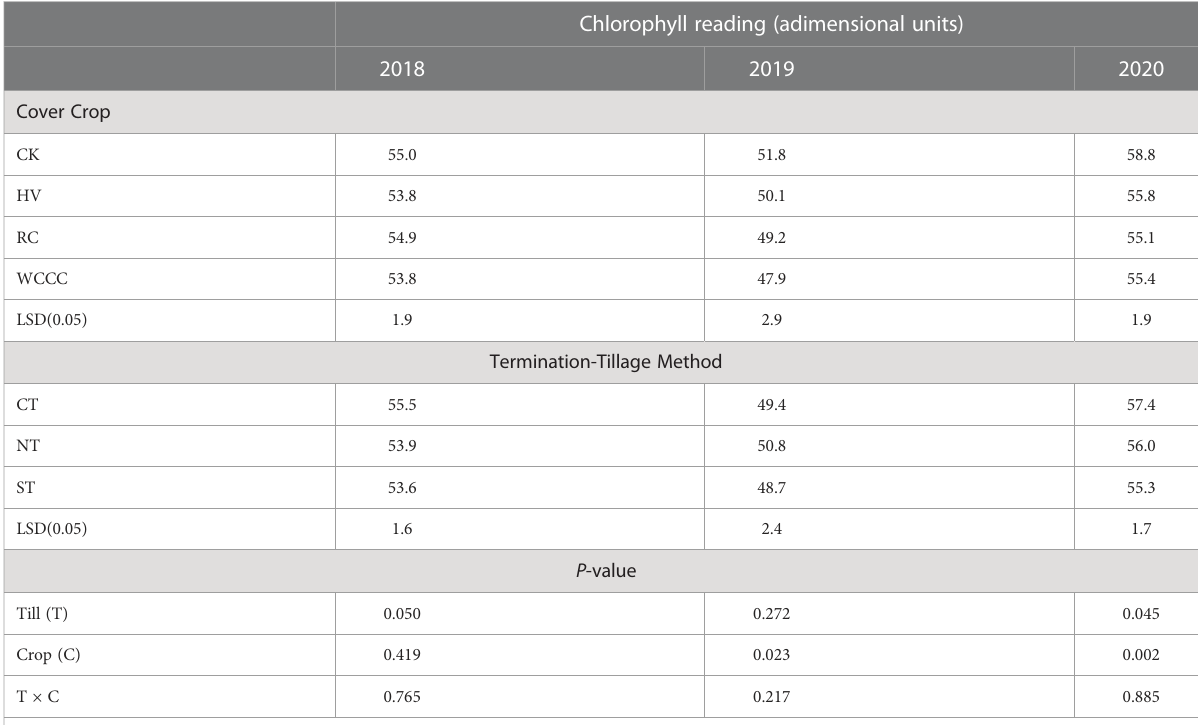
TABLE 4 SPAD-502 chlorophyll meter readings for corn at the R1 growth stage with respect to cover crop species and termination-tillage method in 2018, 2019 and 2020.